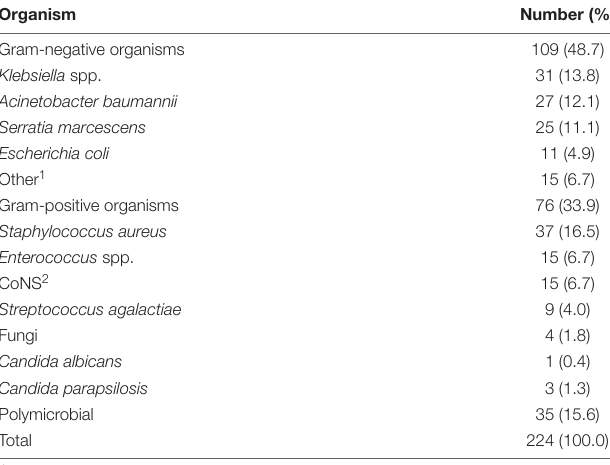
TABLE 3 | Pathogen distribution in proven HAI group (224